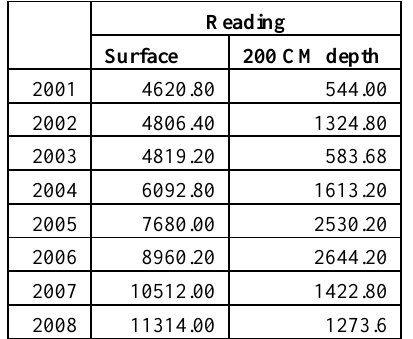
Table 1. The quantification of salts available at